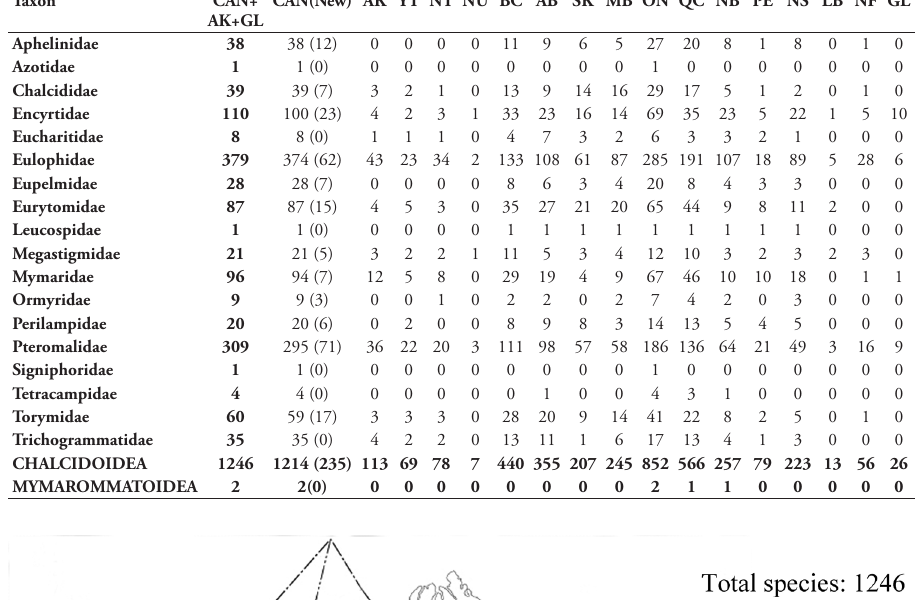
Table 1. Described, recorded species of Chalcidoidea and Mymarommatoidea in Canada, Alaska and Greenland totalled for each taxon and in each region. See Methods for acronyms used for the regions and Fig. 1 for their locations. Regions are arranged generally north to south and west to east. Taxon